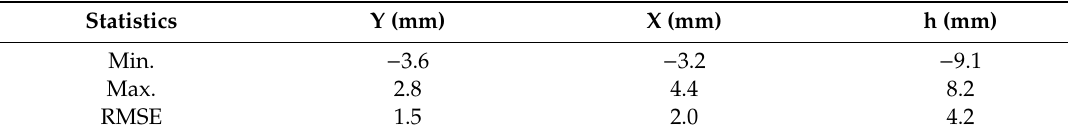
Table 2. Elementary residual statistics for G-baseline.